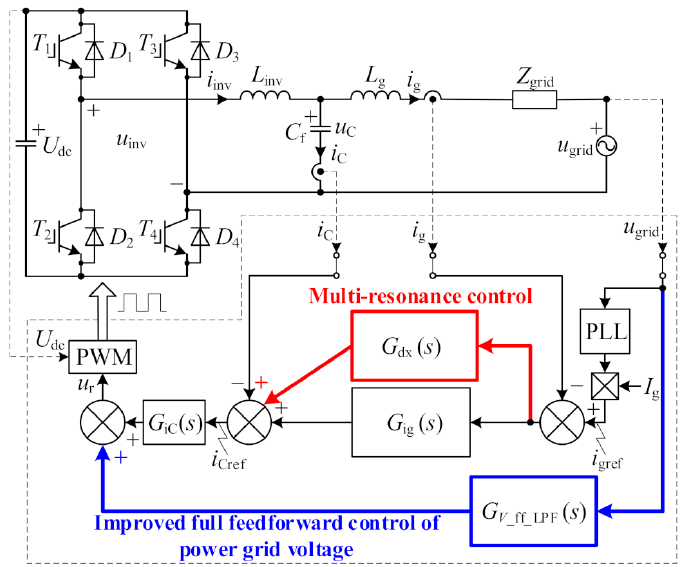
Figure 15. Control structure of Grid-connected Converter (used combined harmonic suppression